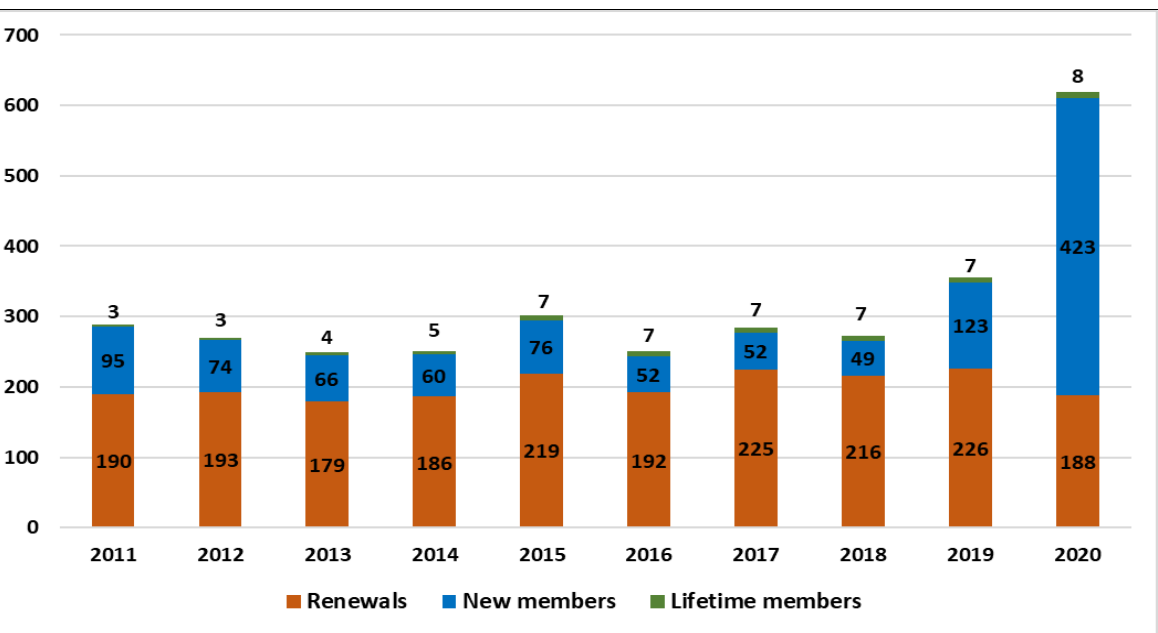
Figure 5. Annual Number of Members by Membership Category, 2011 –